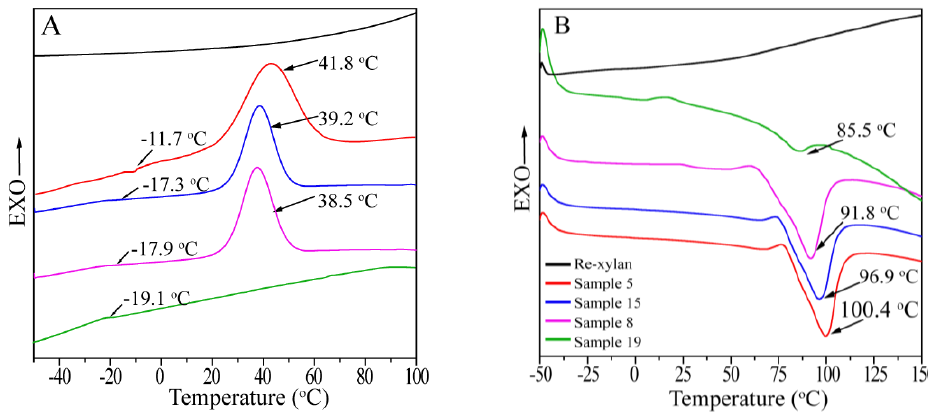
Figure 5. DSC cooling curves ( A ) after erasing the thermal history and subsequent heating curves ( B ) of regenerated xylan, and xylan- g -PPDO copolymer samples 5 (WPG = 431.07%), 8 (WPG = 316.72%), 15 (WPG = 323.15%), and 19 (WPG = 13.03%). Table 2. Data obtained from DSC curves of regenerated xylan and xylan- g -PPDO copolymers with various WPG.